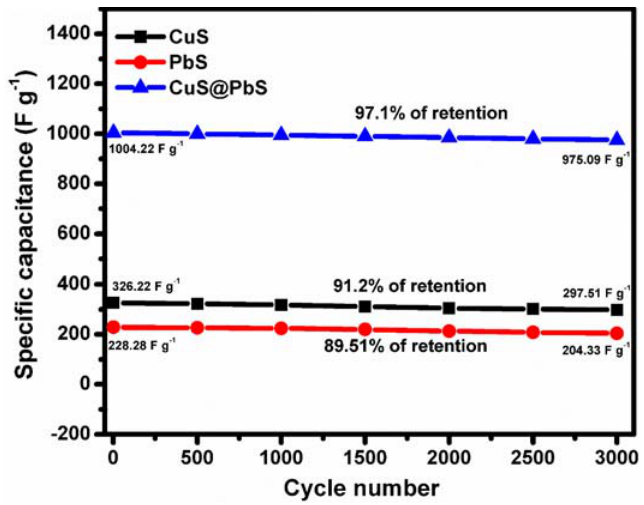
Figure 9. Life cycle of CuS, PbS and CuS@PbS composite electrodes in KOH solution at current density of 2.85 A g − 1 for 3000 cycles.